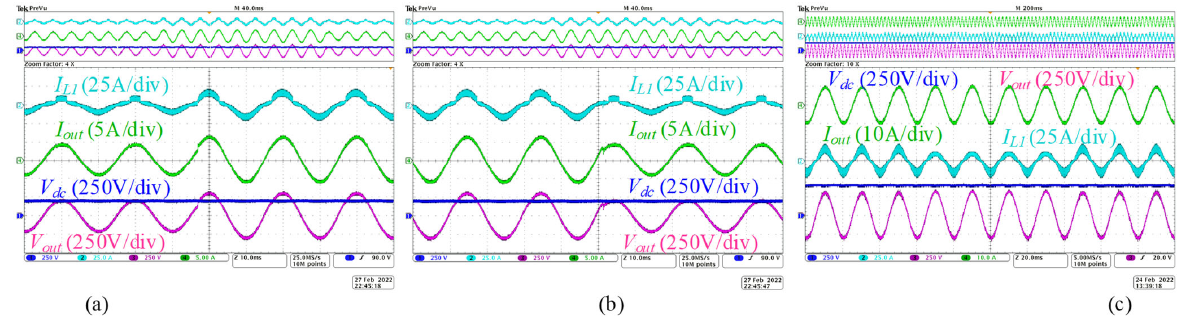
I , I out , V dc , and V OUT from top to bo tt om at , I out , V dc , and V OUT from top to bottom 1 1 L I , V dc , and V OUT from , V dc , and V OUT from 1 L 1